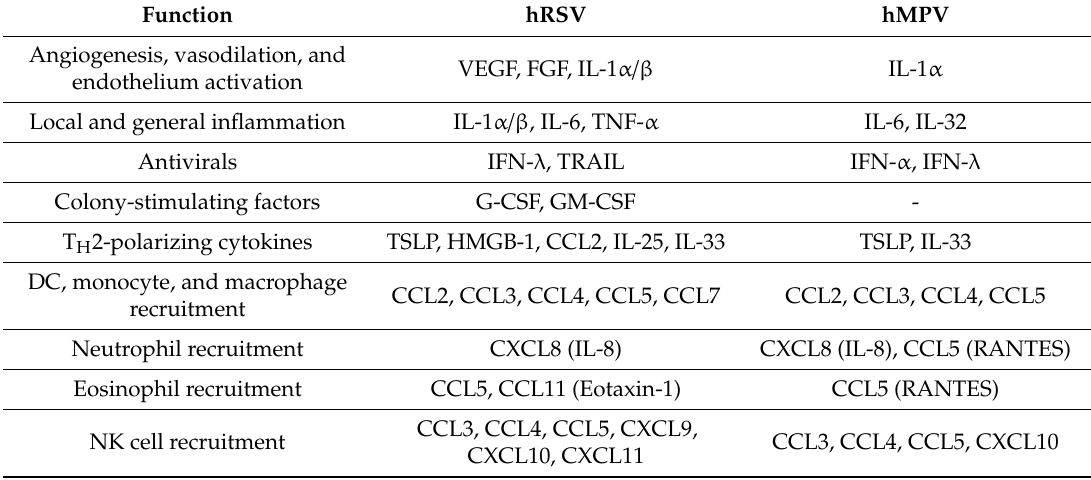
Table 8. Cytokine secretion by epithelial cells during hRSV and hMPV infection.